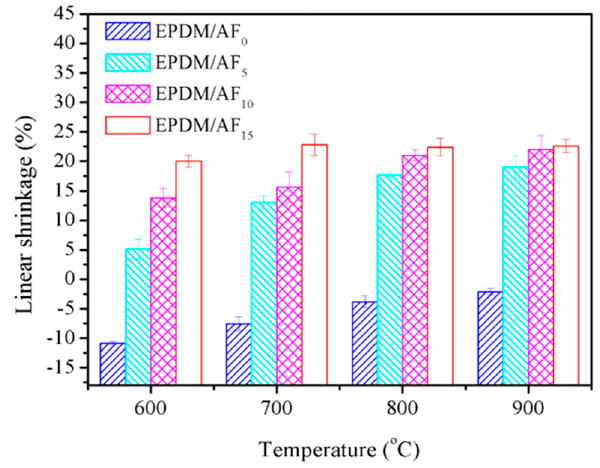
Figure 5. Linear shrinkage of ceramifiable EPDM composites at different temperatures.